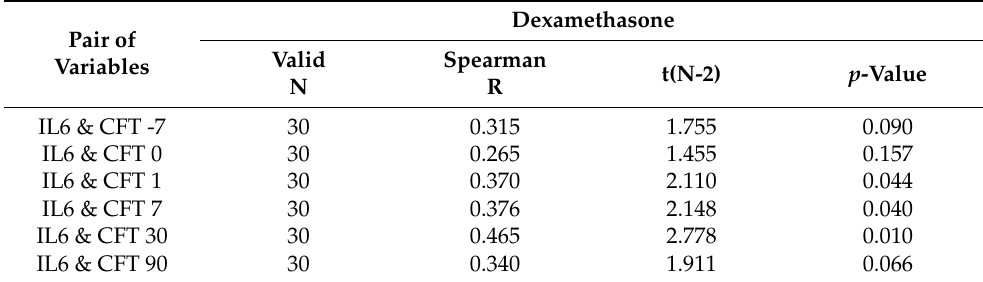
Table 1. Correlation between IL-6 levels (pg/mL) and CFT values ( µ m) in the group treated with